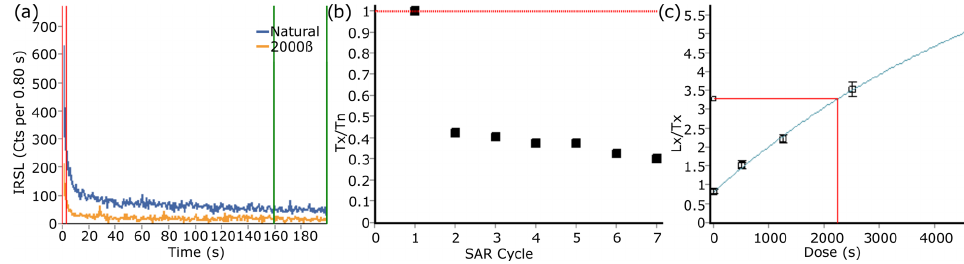
Figure B4. Illustration of luminescence characteristics of the Orakei core sediments using the pIR-IRSL 290 protocol: (a) typical natural pIR-IRSL 290 signal decay for datable sample L14 (A0110); (b) change in sensitivity response to test dose over the regenerative dose cycles for sample L35 (A0116), showing reduction in effective charge transfer throughout the protocol in the typical sample; and (c) dose-response curve for representative aliquot of sample L35 (A0116), showing exponential fit but high Lx / Tx value for the zero-dose step, illustrating a high degree of thermal transfer in the sediments.